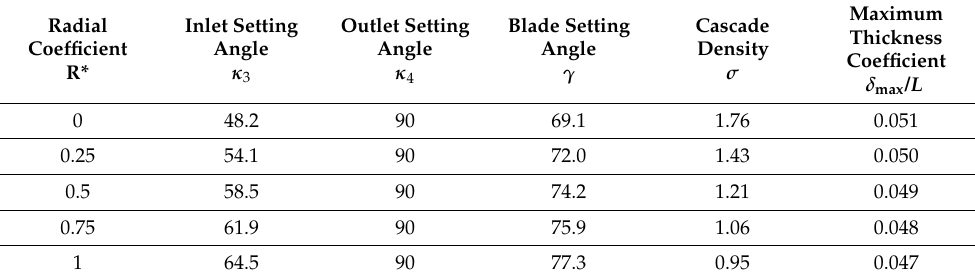
Table 3. The design parameters of guide vane.